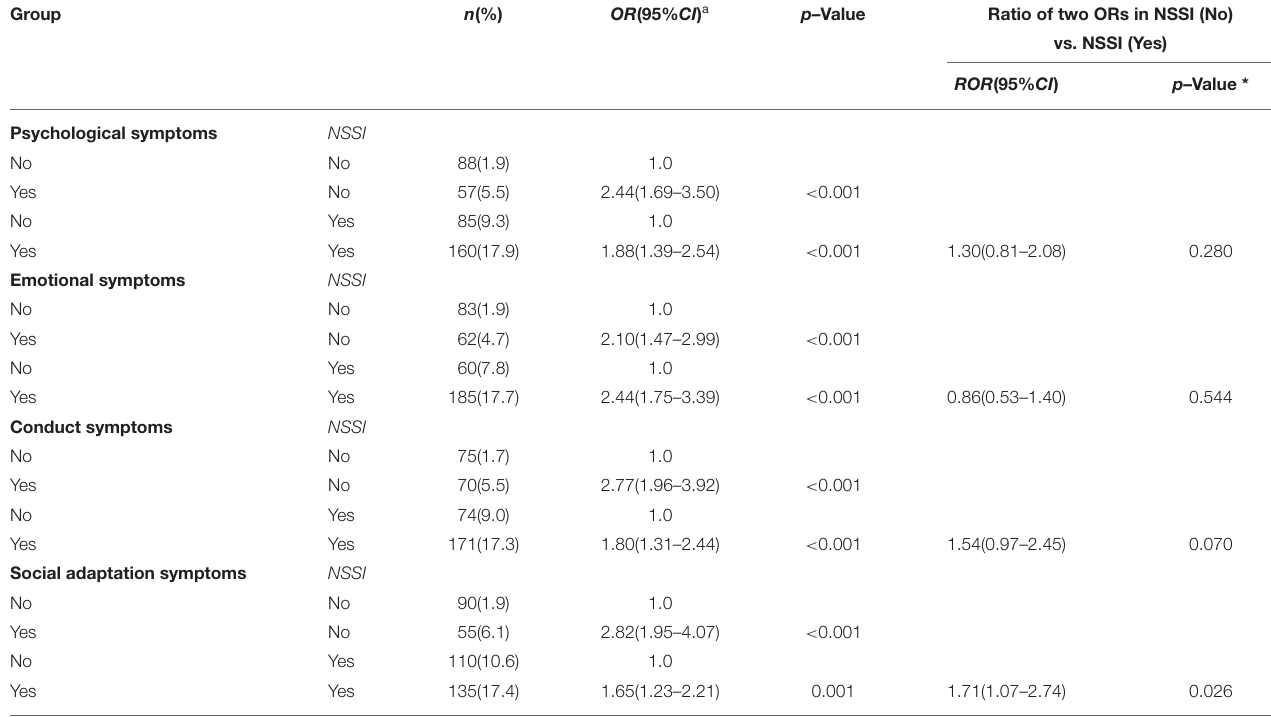
TABLE 4 | Number, % and adjusted OR of SA by psychological symptoms and NSSI in females. Group n (%) OR (95% CI )